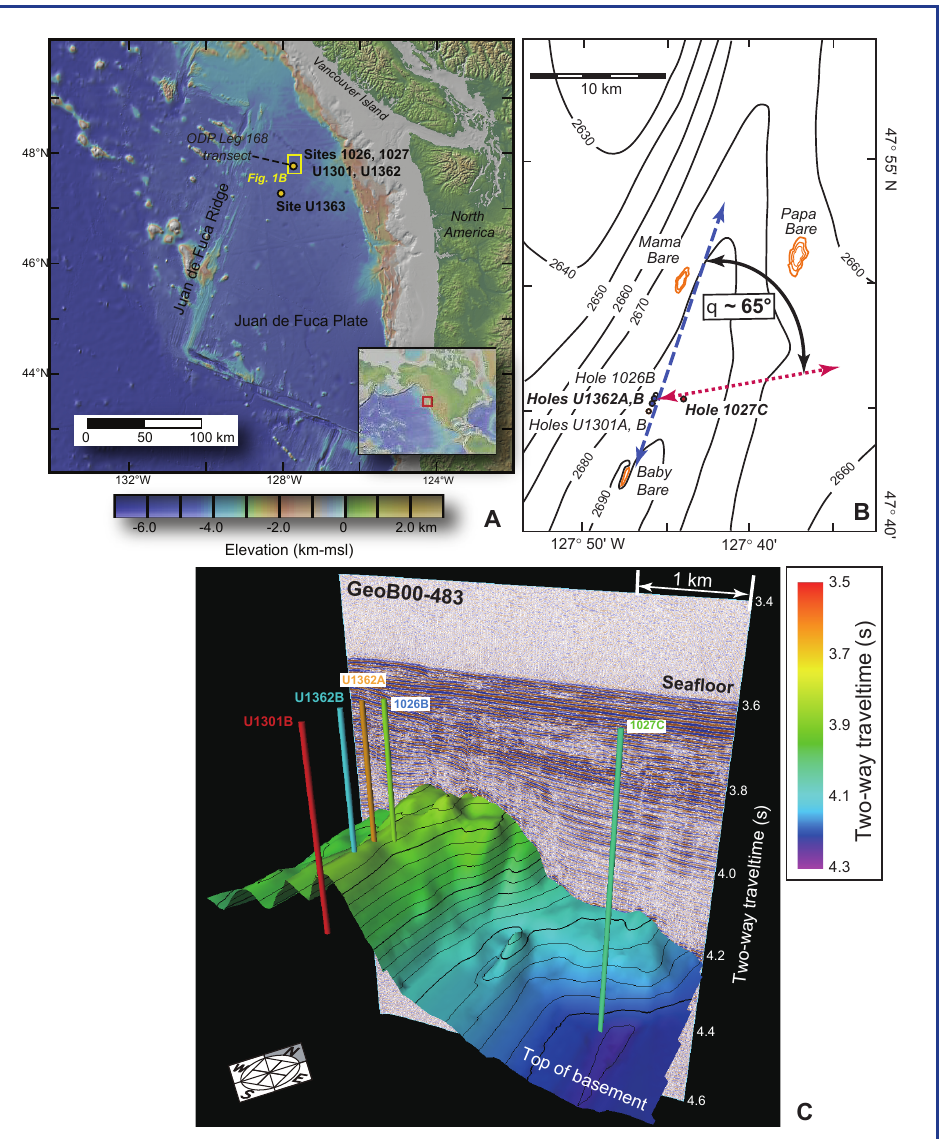
Figure 1. [A] Regional map of field area, eastern flank of the Juan de Fuca Ridge, with inset showing global location. Locations of the ODP Leg 168 transect and sites of IODP Expeditions 301 and 327 and Expedition AT18-07 are shown. [B] Seafloor bathymetric contour map of area around IODP Expedition 301 and 327 sites showing locations of CORK observatories (circles) in Holes 1026B, 1027C, U1301A, U1301B, U1362A, and U1362B, and nearby basement outcrops (gold bathymetric contours) where hydrothermal discharge has been observed (Davis et al., 1992; Wheat et al., 2004b). The blue dashed arrow shows the general structural trend of basement rocks, running sub-parallel to the active spreading center 100 km to the west. The red dotted arrow shows the heading between Holes U1362B and 1027C, which is oriented about 65 ° clockwise from the primary structural trend in basement. Depth contours in meters. [C] Three-dimensional perspective views of basement relief around CORK sites discussed in this paper. Relief is shown as two-way